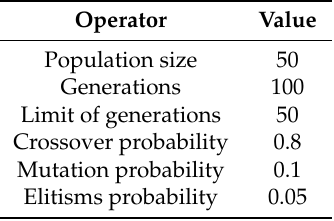
Table 3. Genetic algorithm (GA) parameter